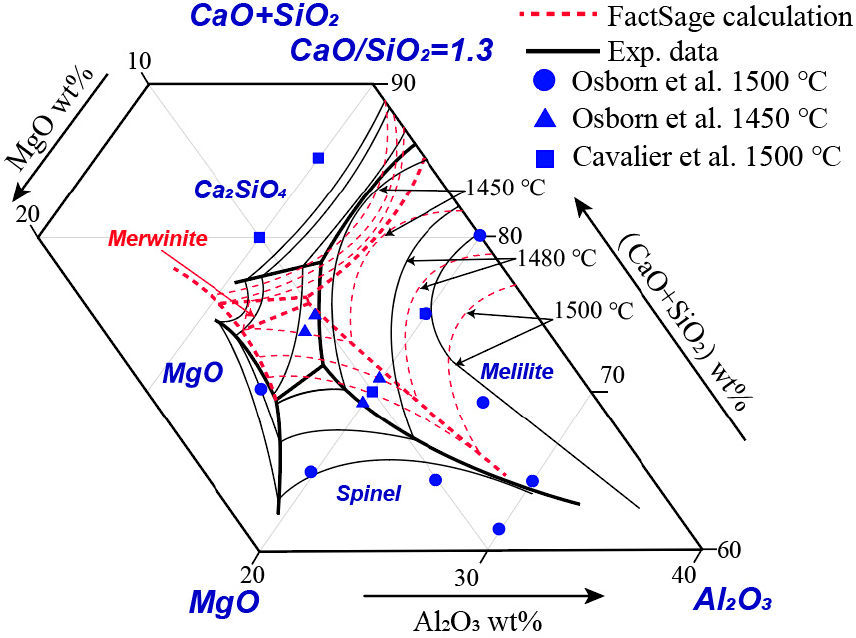
Figure 12. Experimentally determined pseudo-ternary phase diagram (CaO + SiO 2 )-Al 2 O 3 -MgO at a constant CaO/SiO 2 ratio of 1.3 [15] compare with the data reported by Osborn et al. [7], Cavalier et al. [10] and FactSage prediction.